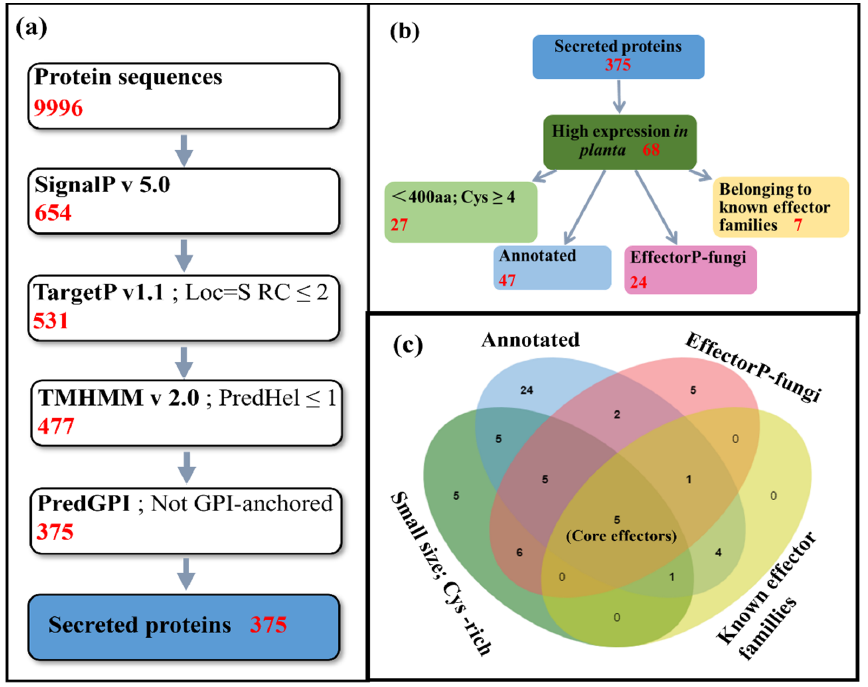
Figure 1. Penicillium italicum secretory protein prediction pipeline ( a ), effector protein prediction pipeline ( b ), and Venn analysis ( c ). In ( c ), 29 optimal candidate effector proteins, with five out of them being core candidate effector proteins, are identified. Green: proteins smaller than 400 amino acids with 4 or more cysteines; blue: proteins with gene function annotation or belonging to known protein families; pink: proteins predicted to be effectors by EffectorP-fungi; yellow: proteins belonging to known effector families or with effector domains that have been previously reported in the literature.